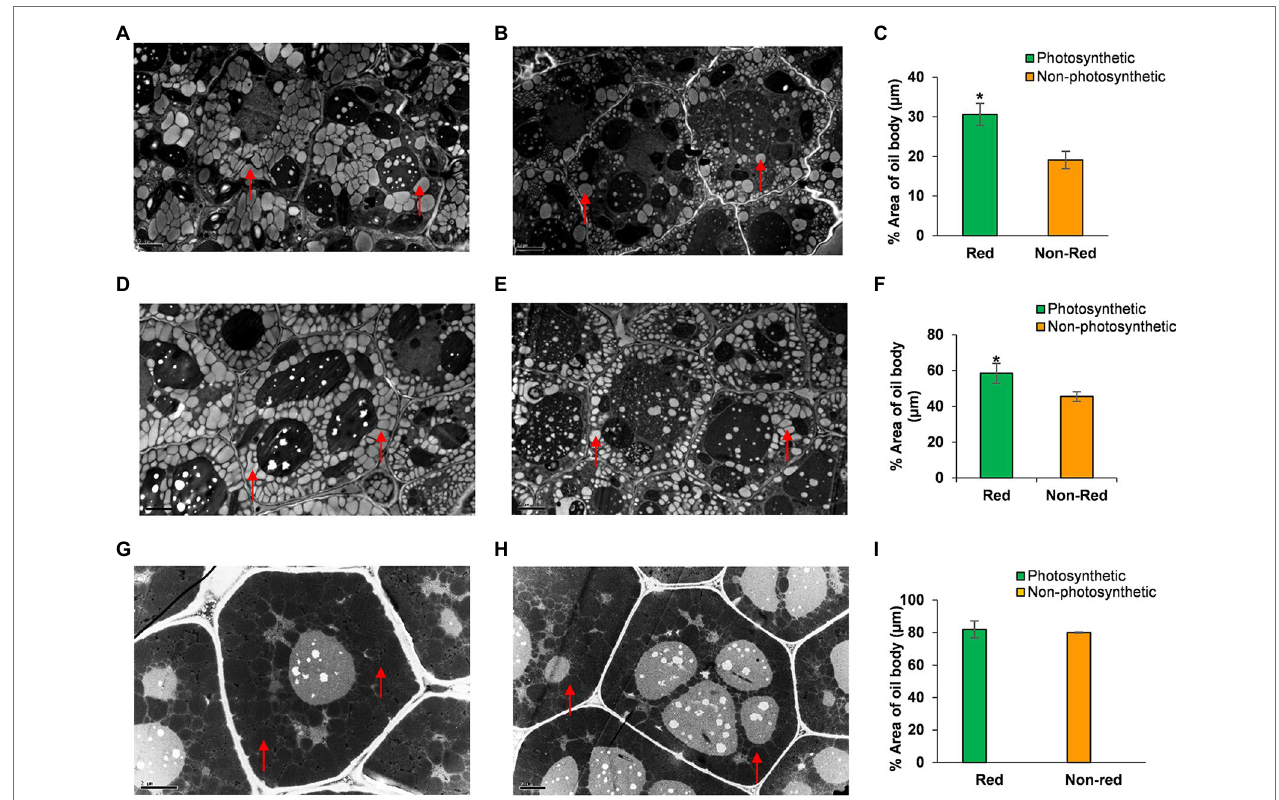
FIGURE 3 | TEM analysis of oil bodies of embryos cotyledons from the same silique of Arabidopsis chlorophyll synthase mutant line CHLSYN7. (A) Section of developing embryos from photosynthetic, green(red) seeds at 8 DAF. (B) Section of developing embryos from non-photosynthetic, yellow(non-red) seeds at 8 DAF. (C) Percentage area of oil bodies per cell of embryos from photosynthetic, green/(red) and non-photosynthetic yellow(non-red) seeds at 8 DAF. (D) Section of developing embryos from photosynthetic, green(red) at 12 DAF. (E) Section of developing embryos from non-photosynthetic, yellow(non-red) seeds at 12 DAF. (F) Percentage area of oil bodies per cell of embryos cotyledons from photosynthetic, green/(Red) and non-photosynthetic, yellow (Non-red) seeds at 12 DAF. (G) Section of embryos from dry seeds (Red). (H) Section of embryos from dry non-red seeds. (I) Percentage area of oil bodies per cell of embryos cotyledons from dry seeds (40 DAF) red and non-red. Red triangles indicate the oil body. Green and orange bars indicate red and non-red seeds of CHLSYN7 seeds. Scale bar = 2 μ m. Values are means from 5 to 6 section obtained from three replicates. Statistical significance was analyzed using the two-sided Student t -test. The asterisk indicates a significant difference ( * p <